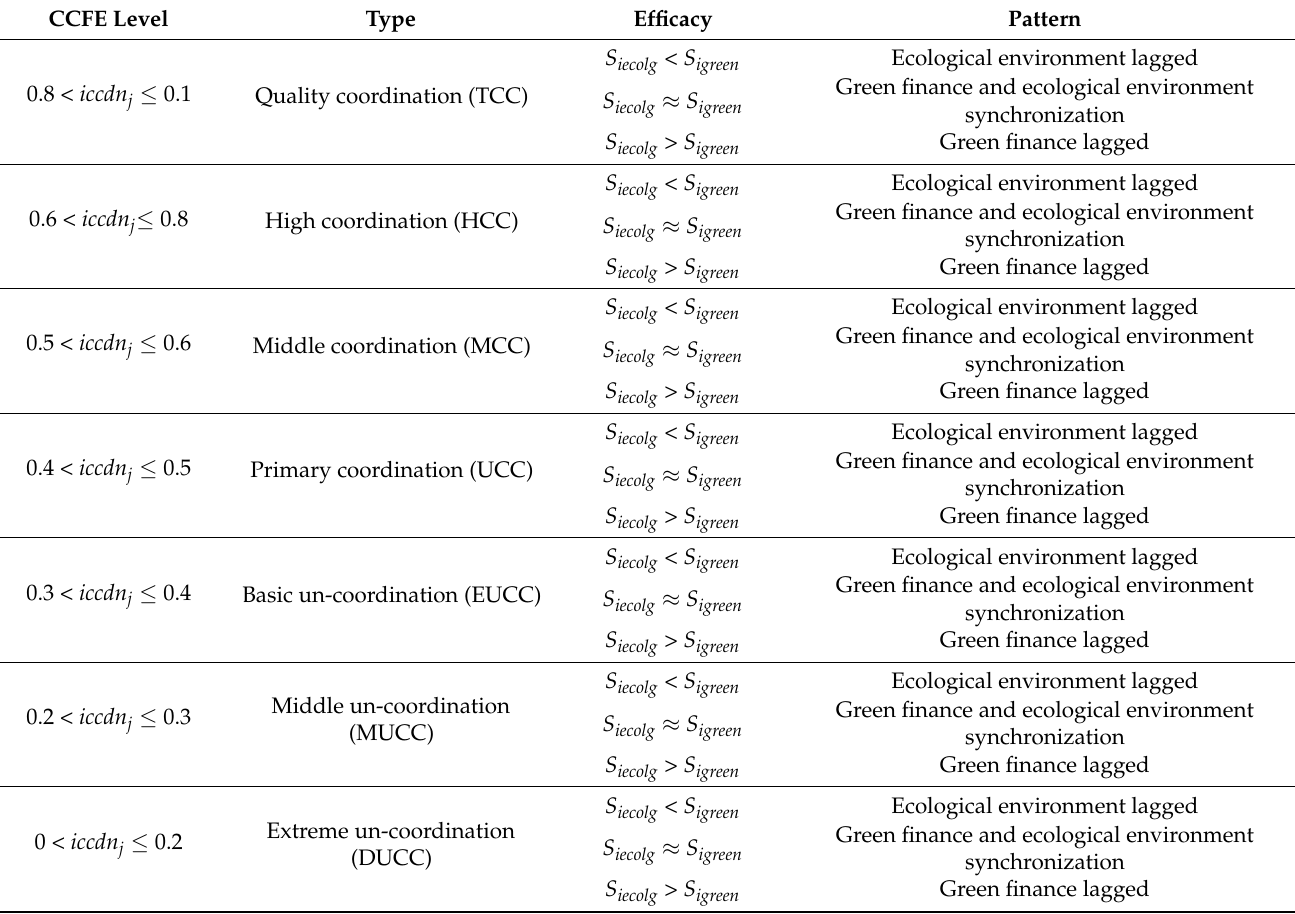
Table 2. The CCFE